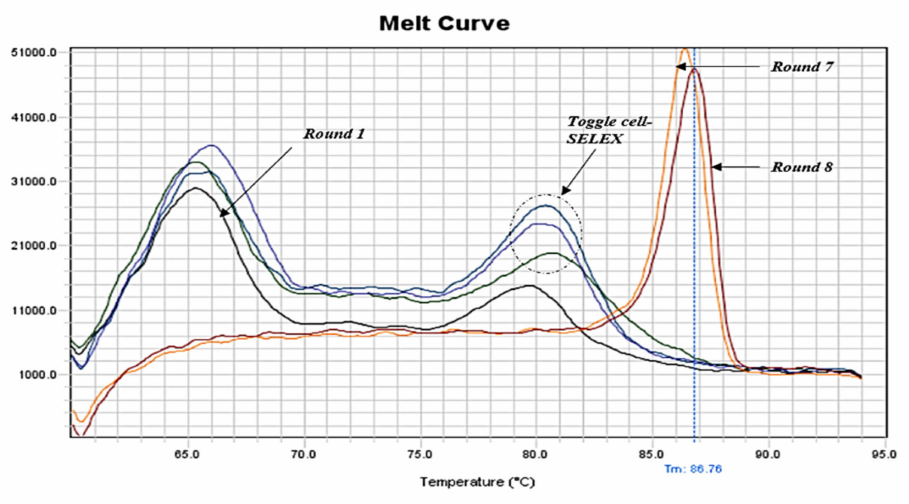
Figure 1. qPCR melting curves of positive cell-SELEX rounds indicating aptamer enrichment and ending of the cell-SELEX